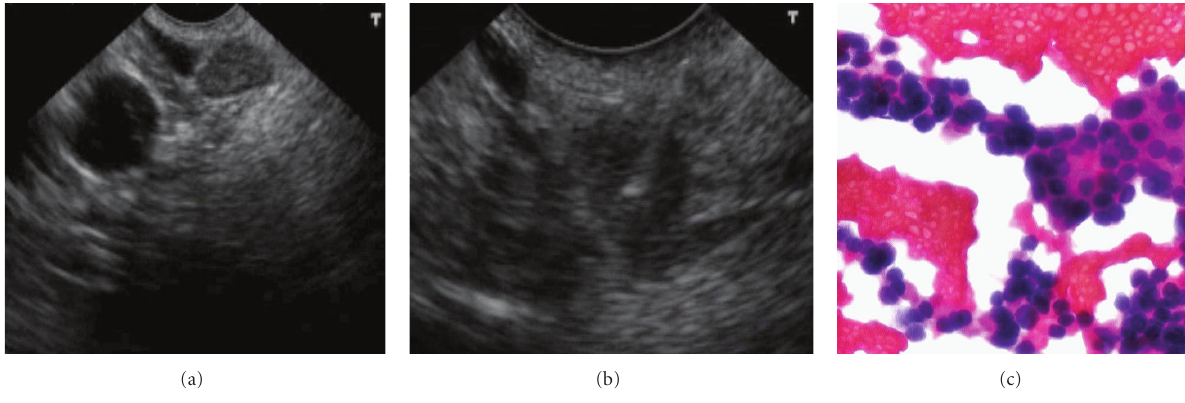
Figure 2: EUS (a), FNA (b), and cytological (c) images of the lymphonodal